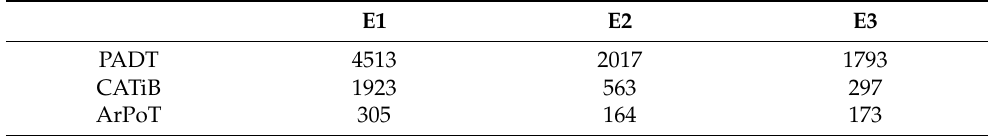
Table 6. Number of labels in each treebank using three head position encodings. E1 E2